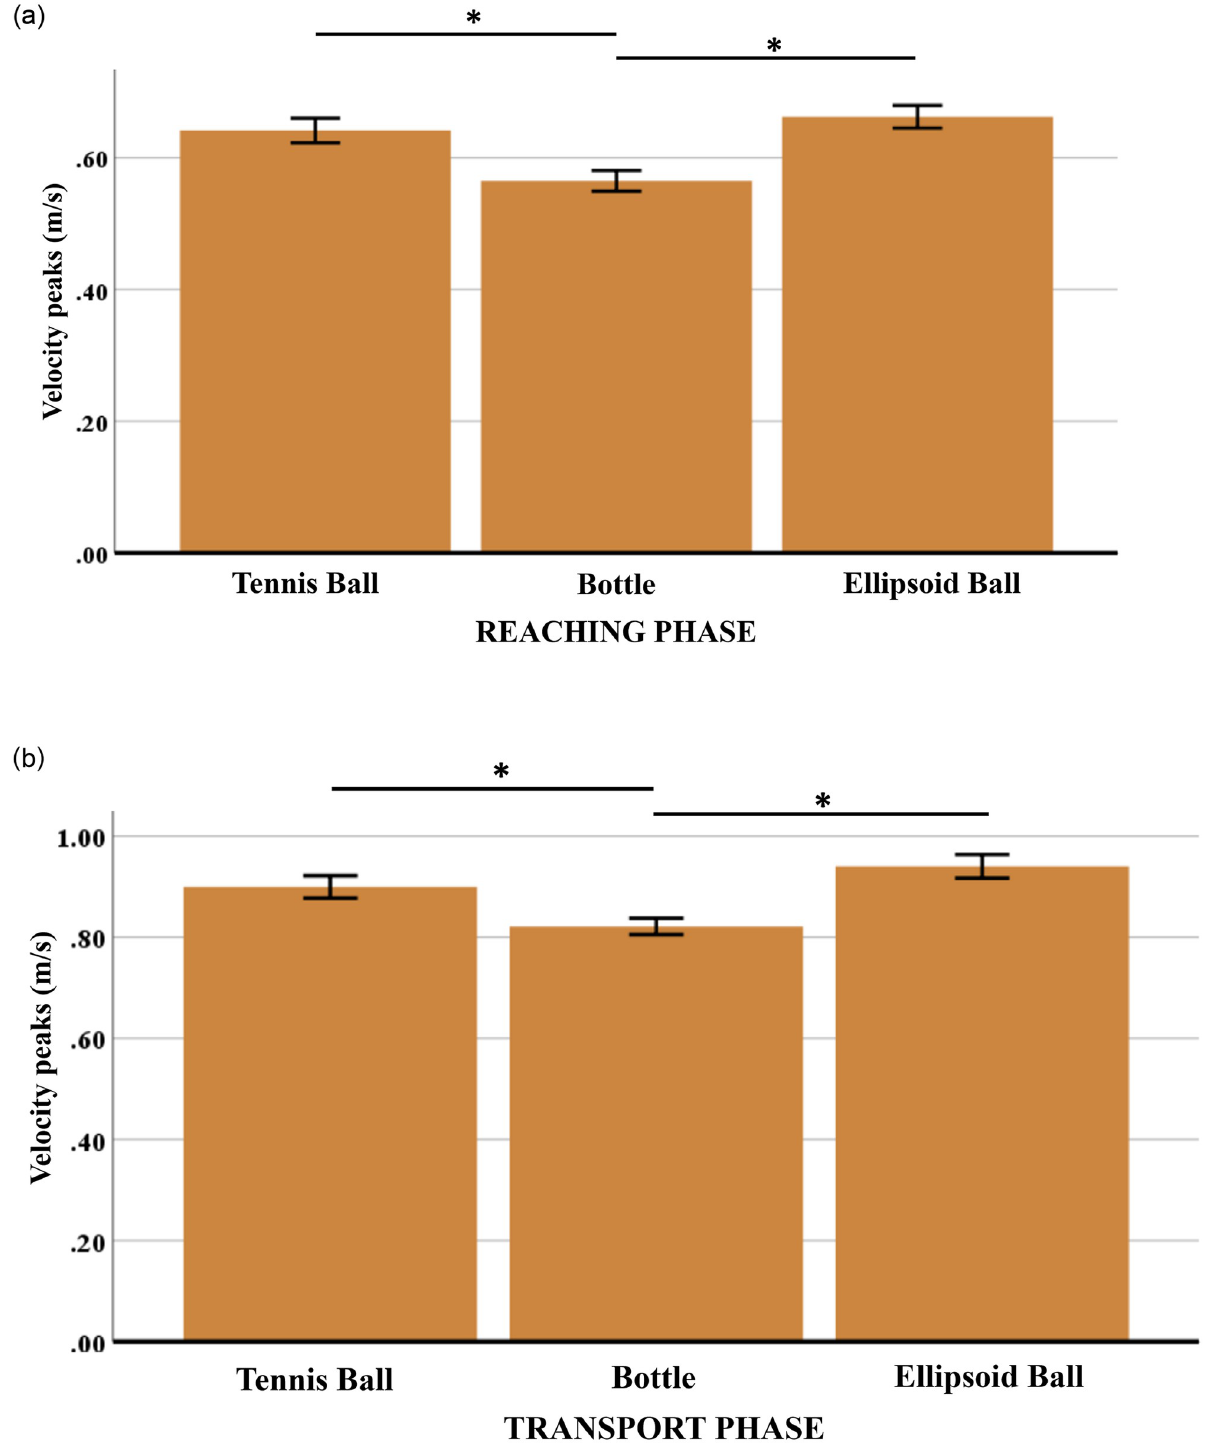
Fig 7. Mean values and SEM (Standard Error of the Mean) of velocity peaks at the reaching (7a) and transport (7b) phase for the three different geometrical objects. Asterisks indicate pairwise significant differences (p-value < 0.001); critical p-value = 0.05/3 = 0.016.